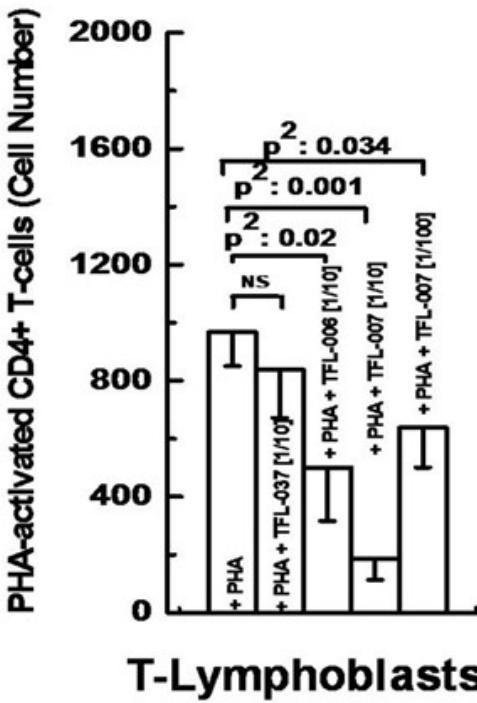
Figure 7. Suppression of PHA-activated CD4+ T-cells by HLA polyreactive monoclonals TFL-006 and TFL-007 at 1/10 dilutions. The control mAb, TFL-037, failed to suppress PHA-activated proliferation, whereas the HLA-I polyreactive mAbs suppressed proliferation significantly. Dosimetric suppression of TFL-007 is shown.